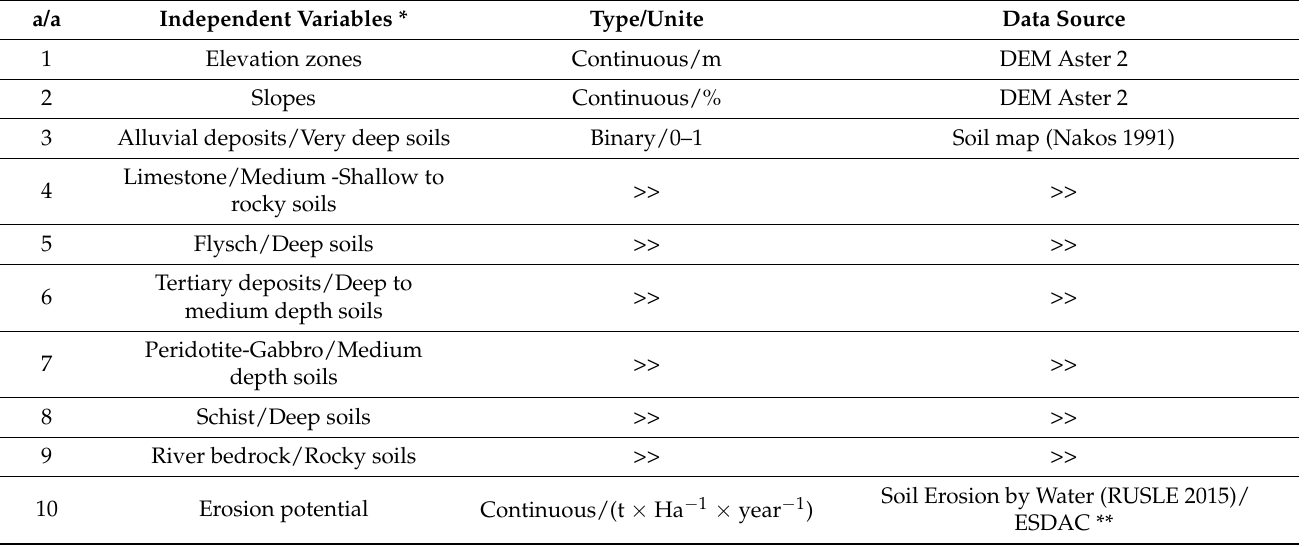
Table 1. Independent variables, type, unit of measurement, and data source for the supply of CLUE-S during the modeling of land use changes of the landscape of Municipality of Mouzaki, Thessaly, Greece.